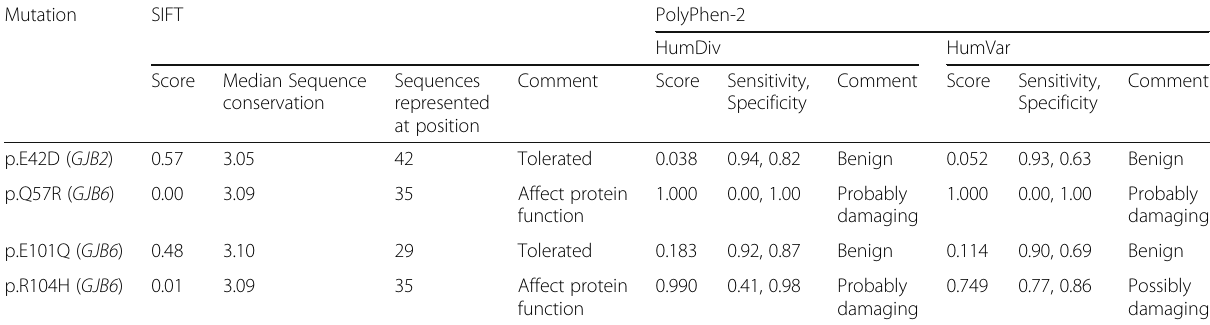
Table 11 Comparative analysis of the SIFT predictions for the novel variants in GJB2 and GJB6 genes Mutation